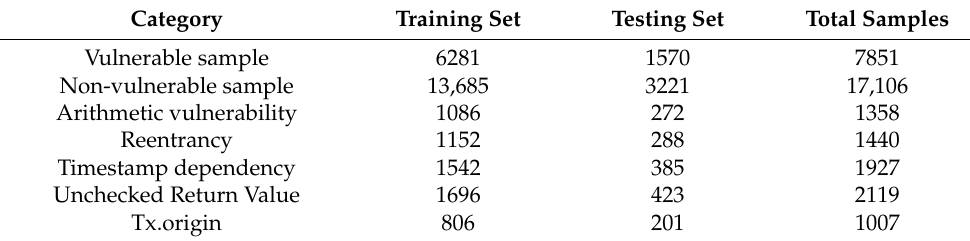
Table 2. Smart contract samples distribution.